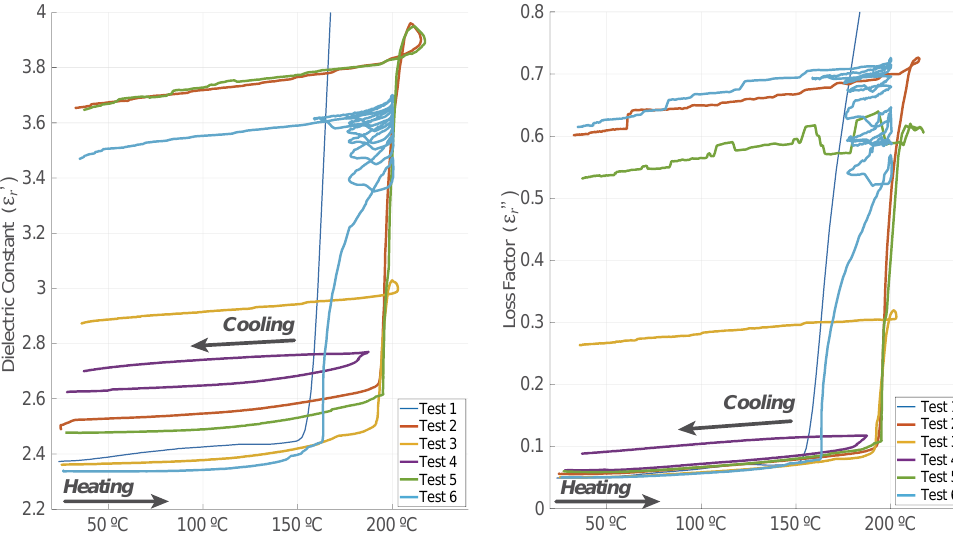
Figure 5. Relative electric permittivity behavior versus temperature for each test (magnified from Figure 4 for a proper visualization of Tests 2 to 6).